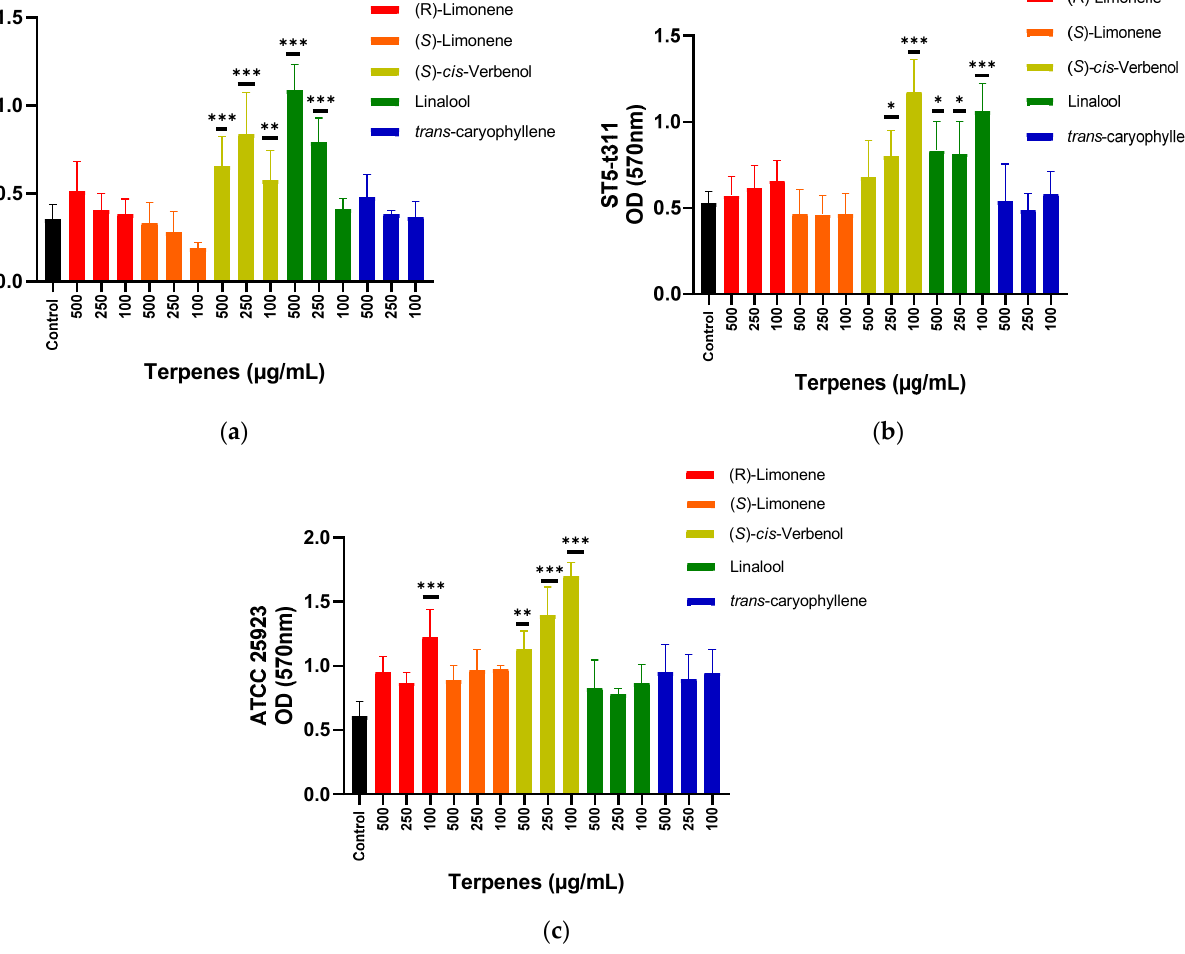
Figure 1. Effect of terpenes on biofilm formation in ST30-t019 isolate ( a ), ST5-t311 isolate ( b ), and ATCC 25923 ( c ). The average of the measurements and the standard deviation are presented in each case. The effect of each concentration is compared with respect to control (one-way ANOVA, Dunnett’s post hoc test). * p < 0.05, ** p < 0.01, and *** p < 0.001 indicate significance.